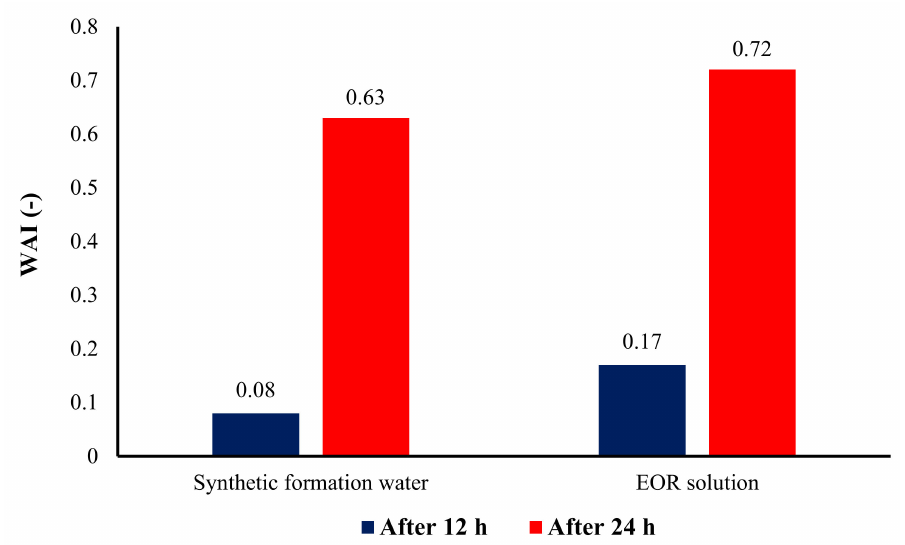
Figure 15. E ff ects of soaking time in di ff erent aqueous solutions on the wettability alteration index (WAI) of the carbonate rock